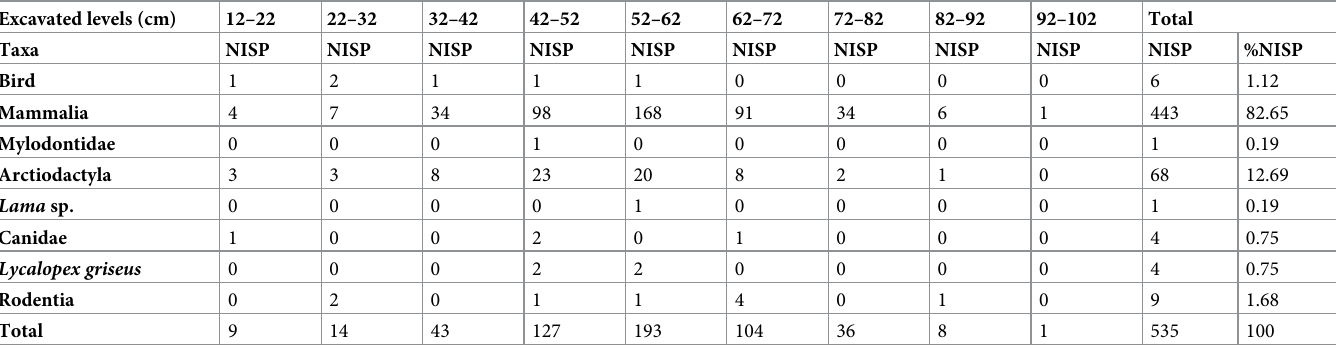
Table 5. Taxonomical identification of bone material across the excavated